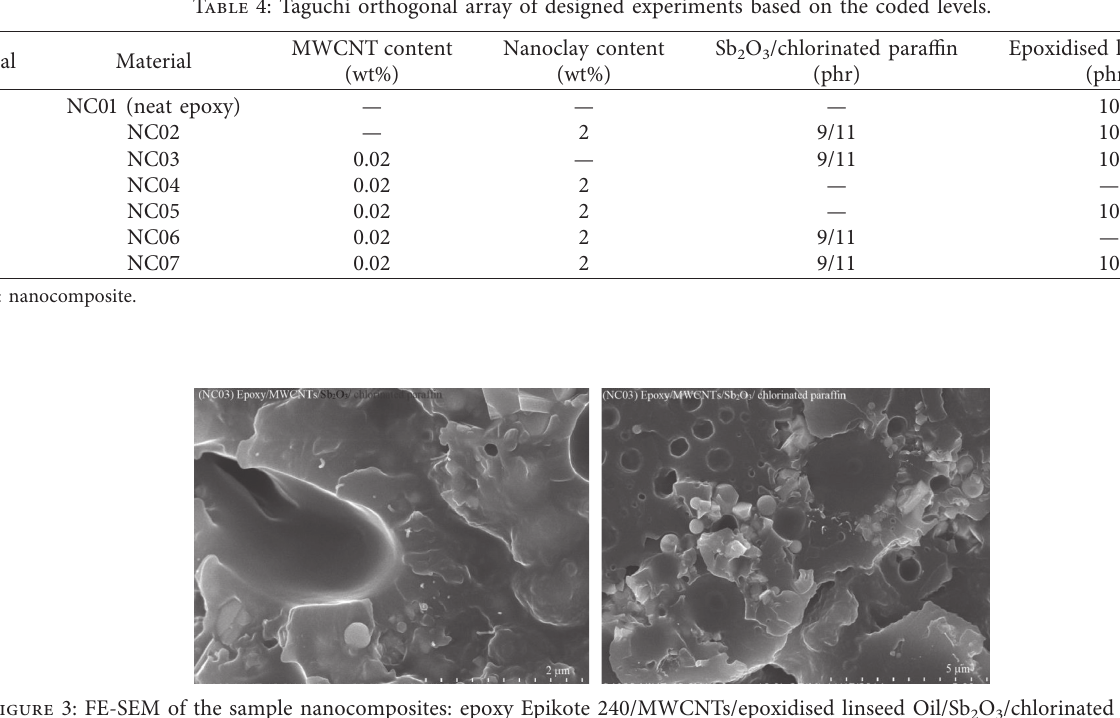
2 O 3 /chlorinated